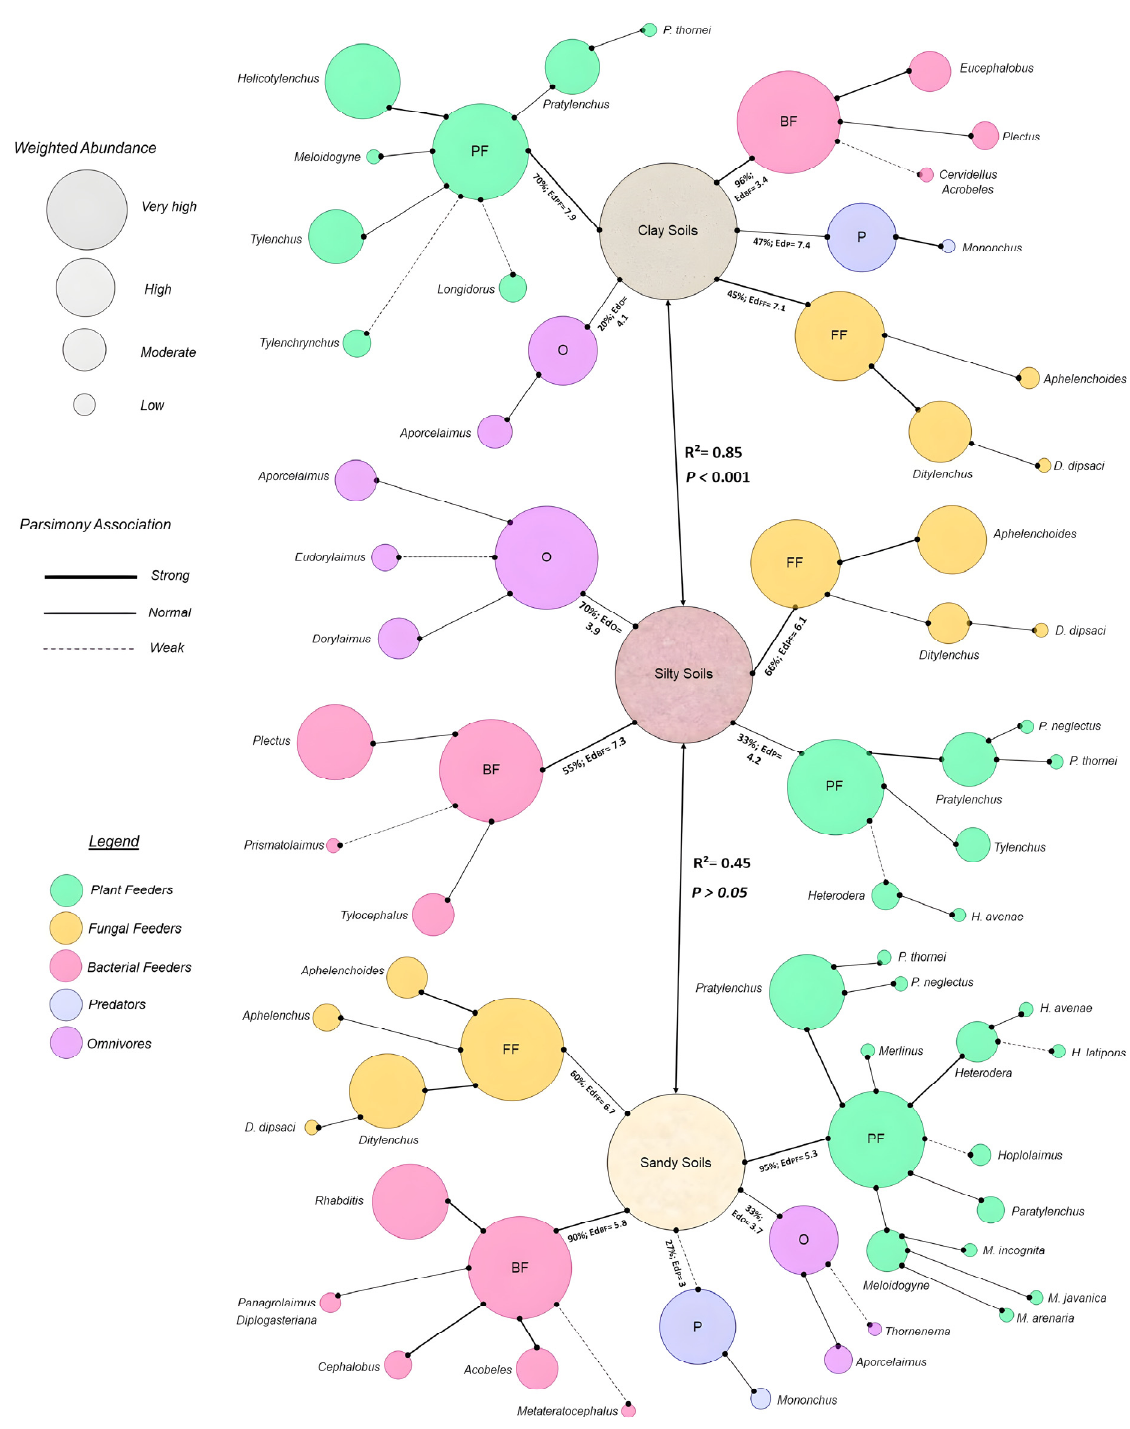
Figure 10. Parsimony mapping network (PMN) shows the association between soil type and nema- tode feeding types. Contribution values from multidimensional spatial bubble plots were projected and clustered for different soil patterns. The associated taxa and their affiliation strength were predicted using the Euclidean distance based on a dissimilarity matrix between all localities with similar soil patterns and linkage percentages. Weighted abundance was computed for each feeding type. The plot was generated using BioPython matplotlib library with Bio.Phylo module [57] and NetworkX library [58] in PyCharm API.